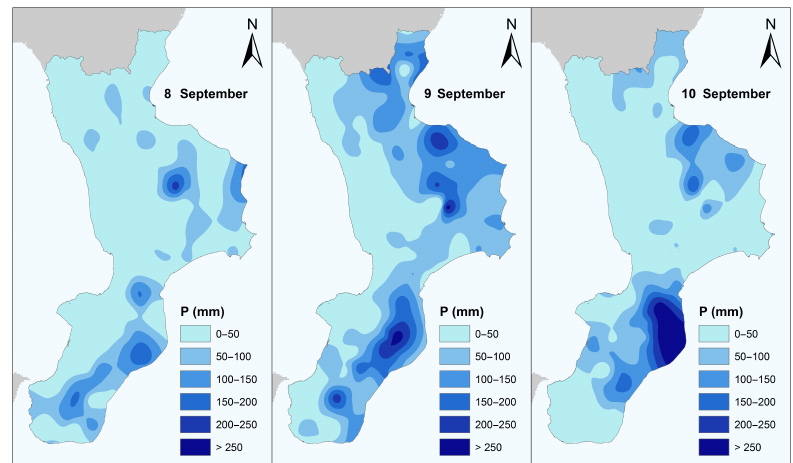
Figure 4. Spatial and temporal distribution of the daily rainfall for the September 2000